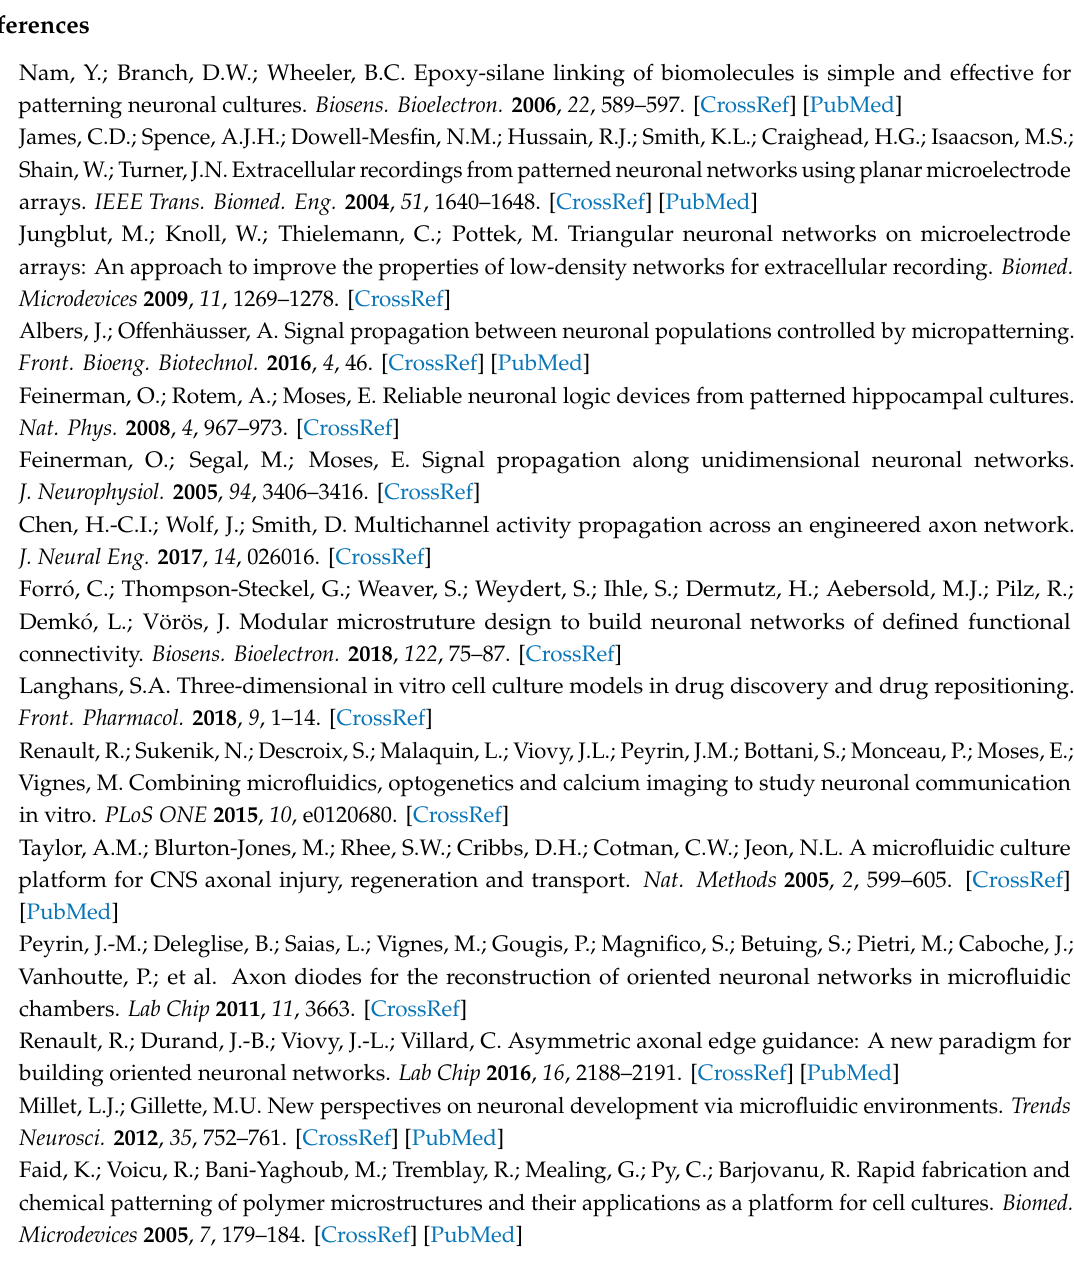
Figure S4: Alternative representations of the long-term stability of Glymo on glass, Table S1: Results of Dunn’s test with Bonferroni corrected p values for cells outside of patterns established with Glymo and DDA background hydrophobization, Table S2: Results of Dunn’s test with Bonferroni corrected p values for neurites outside of patterns established with Glymo and DDA background